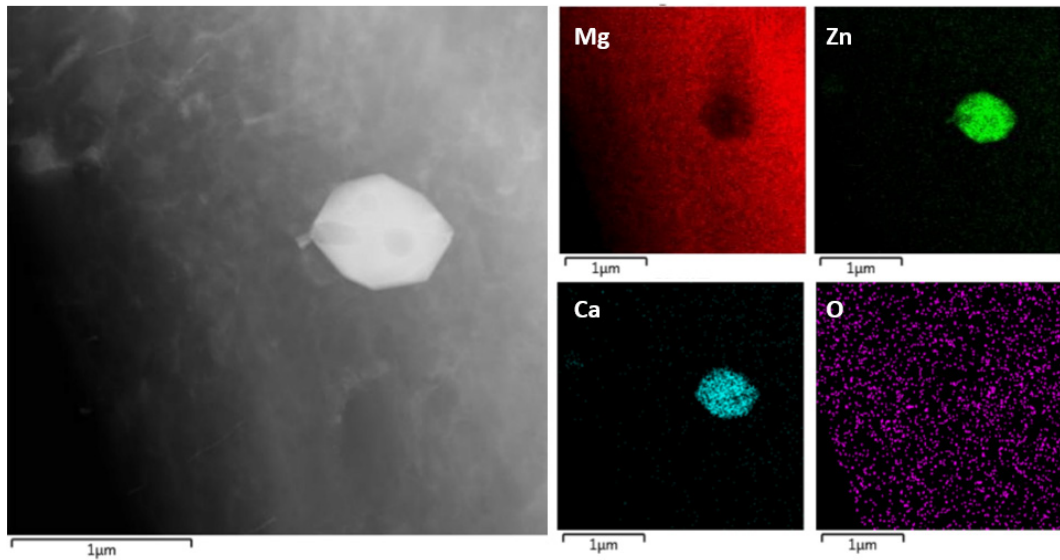
Figure 18. EDS maps of a P1 precipitate in a Mg5Zn0.3Ca sample. These precipitates contain Zn (green) and Ca (blue); Mg (red) was mainly observed in the surrounding matrix. O (pink) appeared in all sample areas; it most likely came from the atmospheric oxidation of prepared TEM foils.